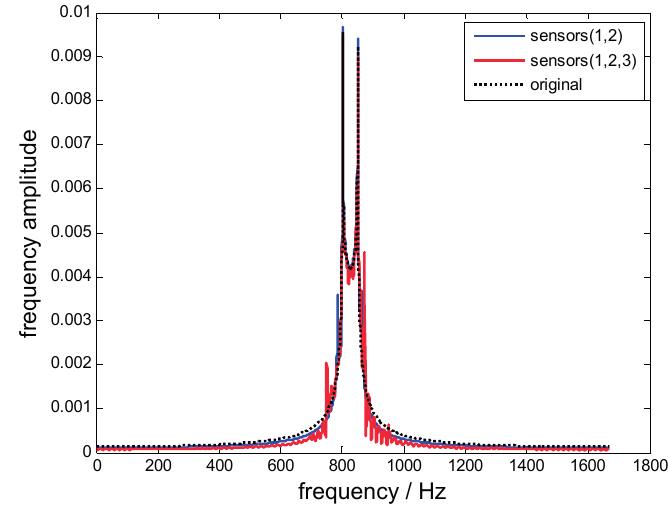
Figure 8. Frequency spectra of reconstructed signals.